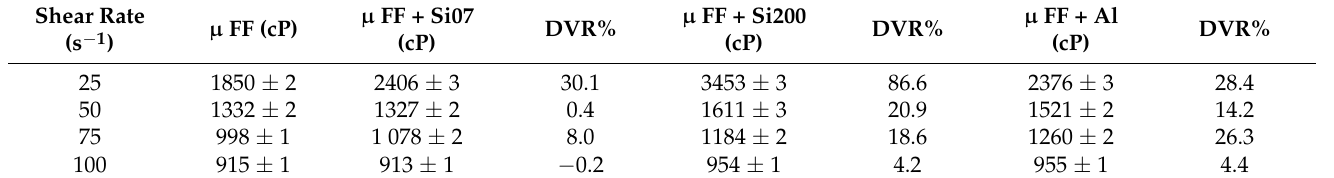
Table 6. Rheological measures of the original FF in the absence and presence of Si07, Si200 and Al at